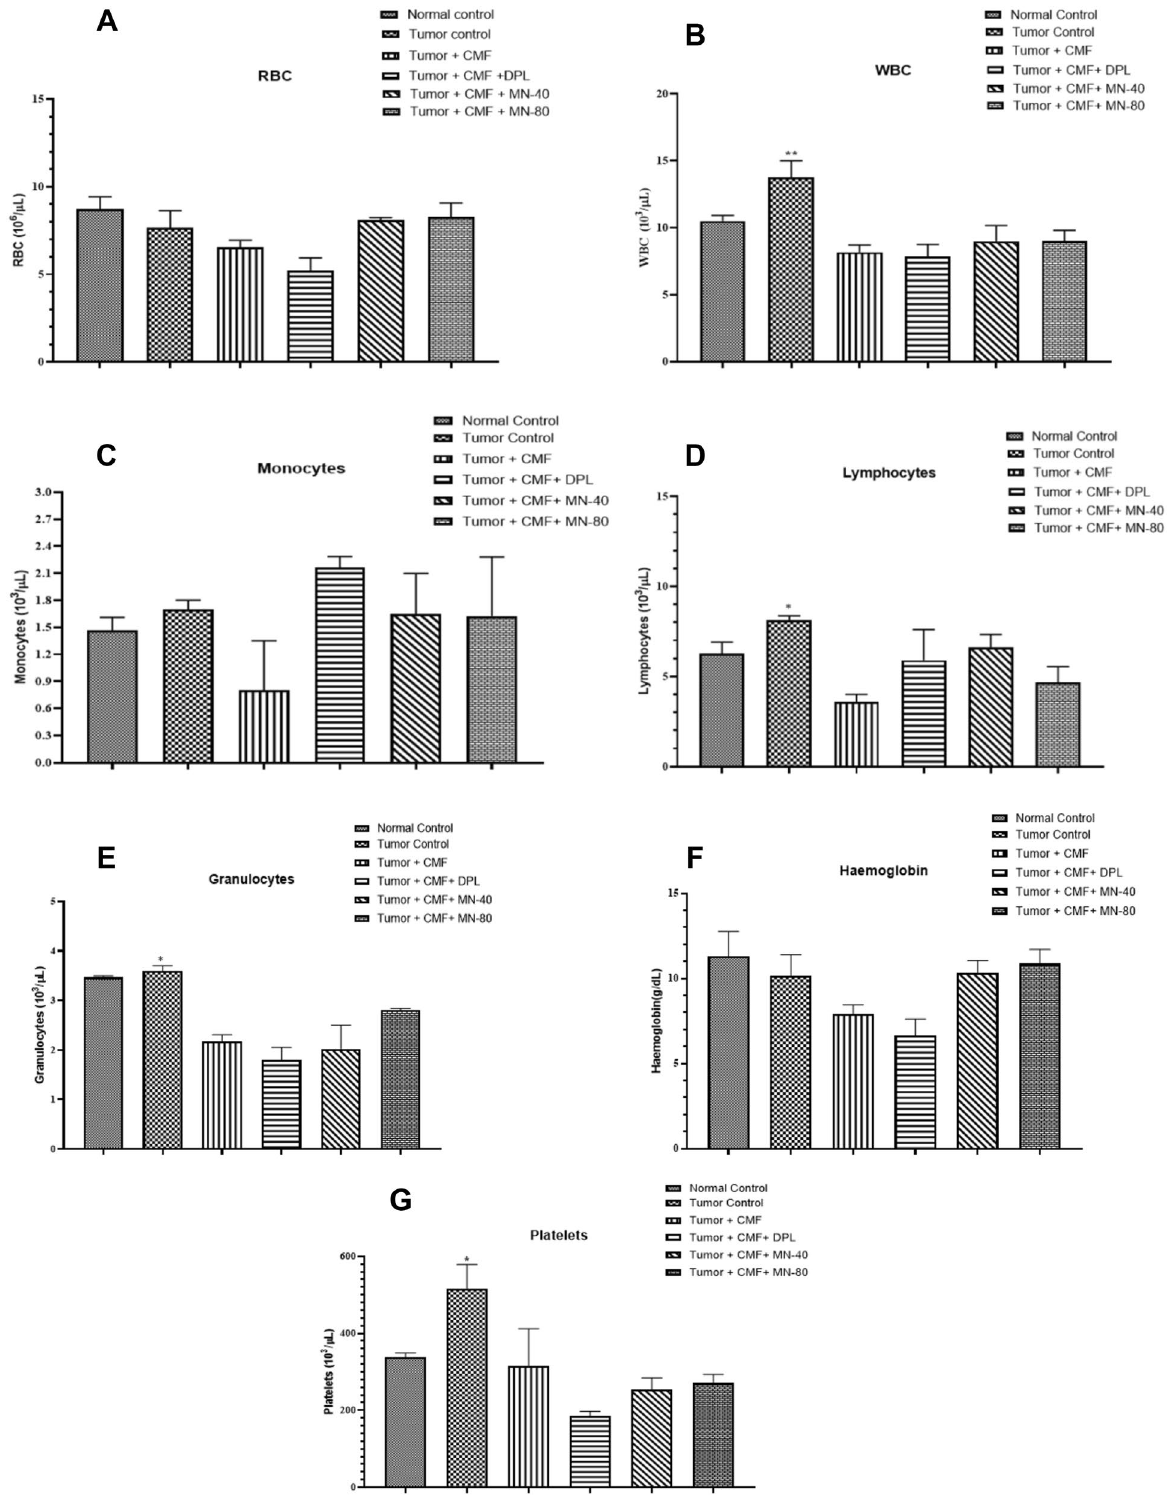
Figure 7. Effect of Mulmina (MN), Cyclophosphamide + Methotrexate + 5-Fluorouracil (CMF), Donepezil (DPL) on A) Red blood cell B) White blood cell ( C ) Monocytes ( D ) Lymphocytes ( E ) Granulocytes ( F ) Haemoglobin ( G ) Platelets on tumor-bearing animals. Values are expressed as mean ± SEM (n = 3–4). Statistical analysis was done by using one-way ANOVA followed by Dunnet’s post-hoc test .*p < 0.05,**p < 0.01 compared to tumor + CMF treated